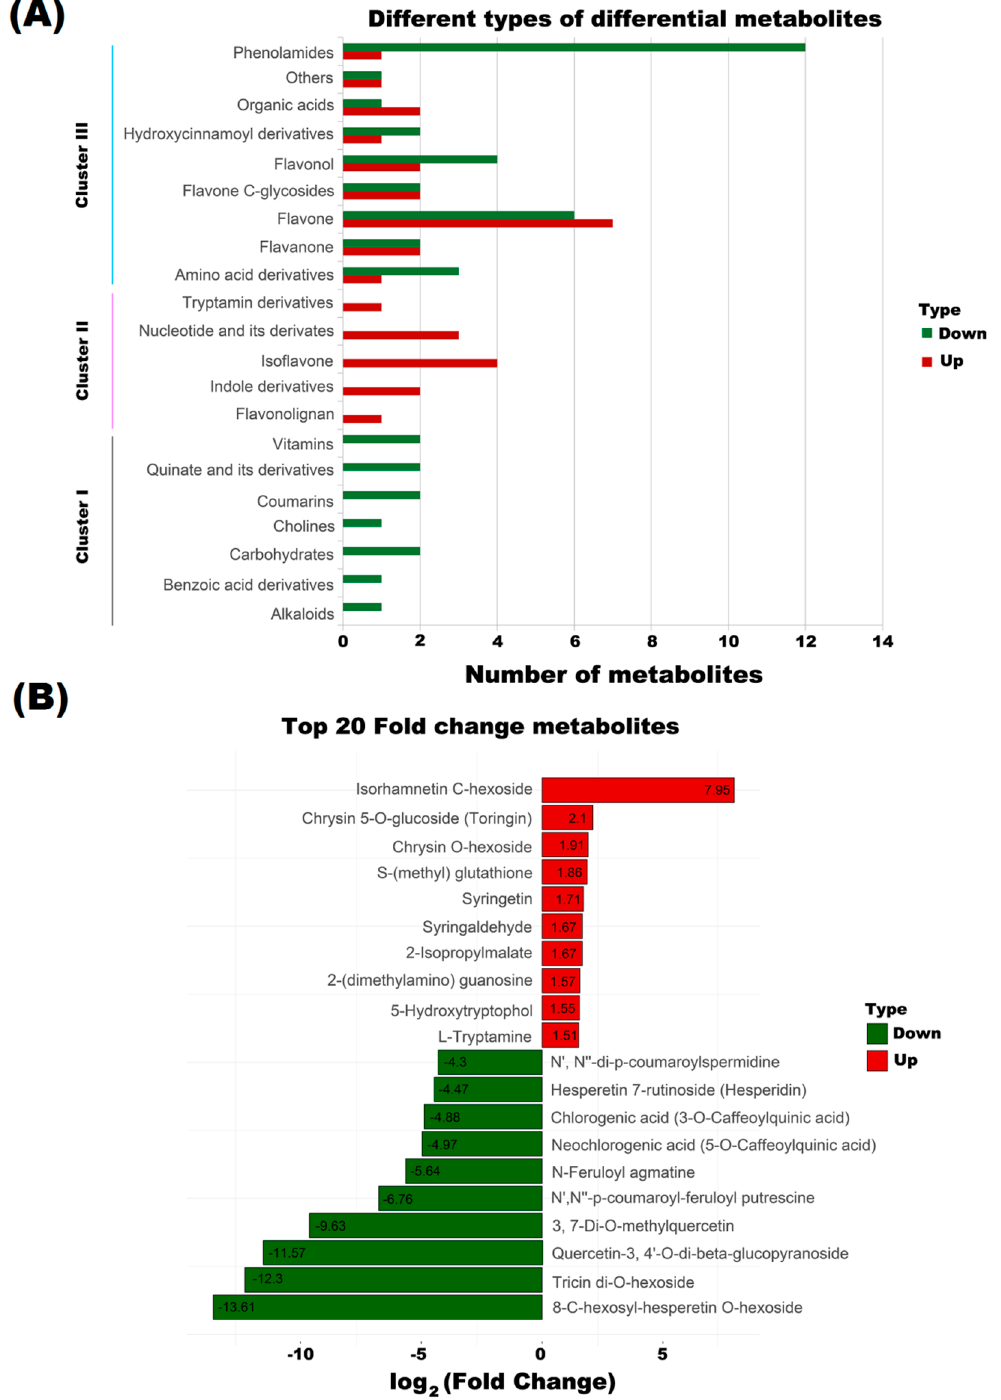
Figure 4. Cluster of di ff erent types of di ff erential metabolites for NJCMS5A and NJCMS5B. ( A ) Cluster of di ff erent types of di ff erential metabolites between NJCMS5A and NJCMS5B; ( B ) Top 10 up-regulated metabolites and top 10 down-regulated metabolites.